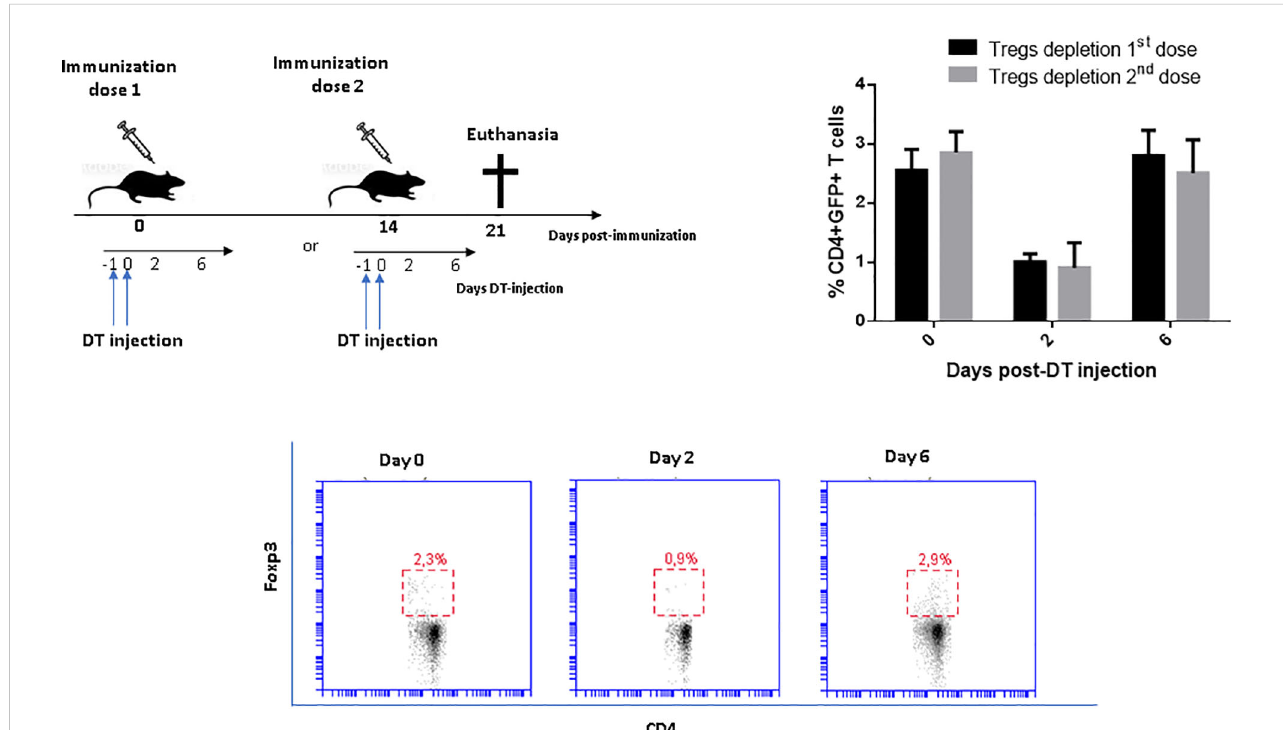
FIGURE 1 Kinetics of Tregs depletion in vaccinated DEREG mice with a recombinant-based vaccine against Sporothrix spp. The consecutive intraperitoneal application of DT over two days leads to a depletion of eGFP+Foxp3+ Tregs within 48 h and complete recovery around the sixth day of DT administration. The percentage of CD4+GFP+ Tregs in peripheral blood was measured by fl ow cytometry at the indicated time points. There were no differences in the magnitude of Tregs depletion at priming and boosting. Wild-type littermates mice also received similar DT treatment during the boosting without effects on Tregs frequency (results not shown). Two-way ANOVA analysis revealed signi fi cant differences (p<0.0001) on day 2 compared to days 0 and 6 after DT injection in both groups, with no difference between them at any time